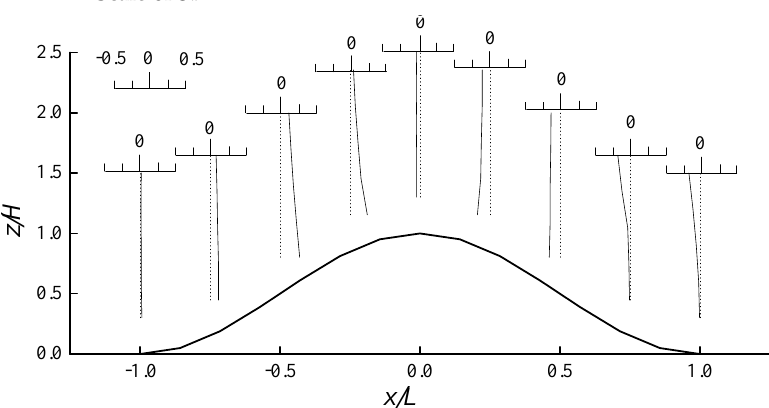
Figure 10. The vertical wind component ratio S w on the along ‐ wind center line of the hill ( y = 0).